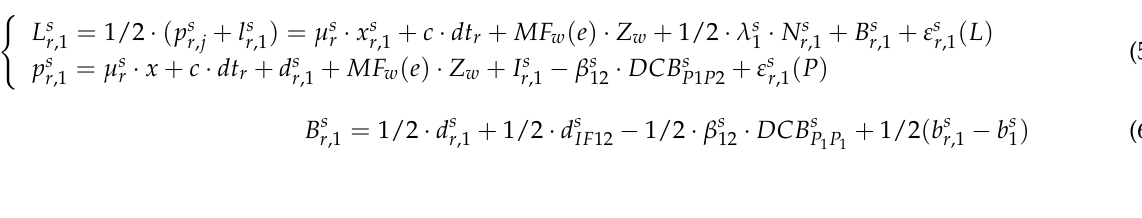
Figure 1. Presentation of the TGD relationship (This red line indicates that B3 is the